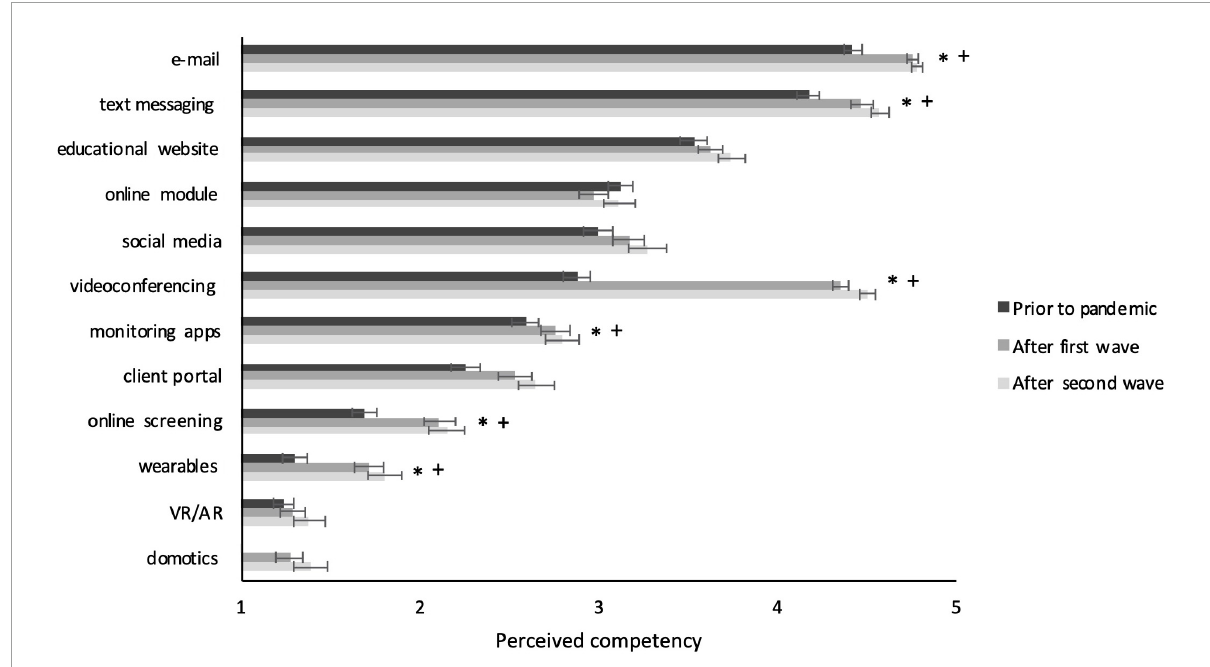
FIGURE4 Perceived value of individual DMH tools per survey. Significant effects with Cohen’s d > 0.25 are indicated with ∗ for comparison between Survey 1 and 2 and with + for comparisons between Survey 1 and 3. Error bars present the standard error of the mean.